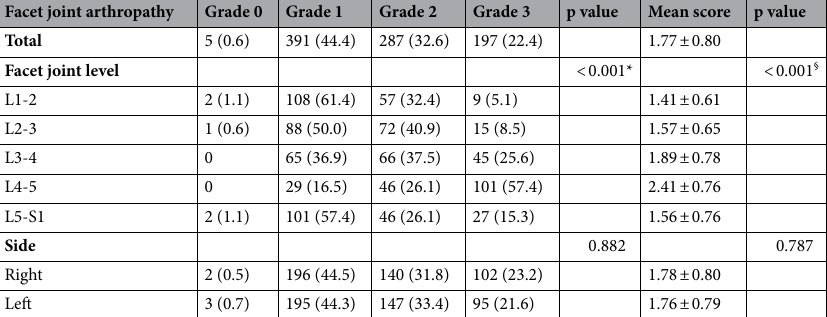
Table 1. Grading analysis of preoperative facet joint arthropathy based on Weishaupt’s classification. The data are expressed as number (%) or mean ± standard deviation. * Statistical differences were examined by Fisher’s exact test. § Statistical differences were examined by Kruskal–Wallis test. *indicated statistical significance.